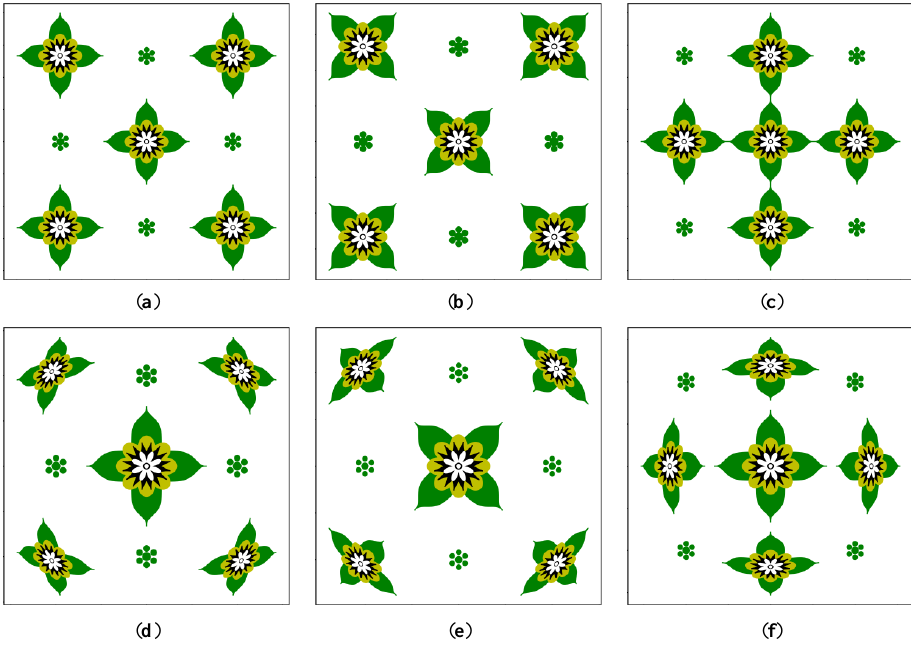
Figure 10. The final flower pattern layouts.